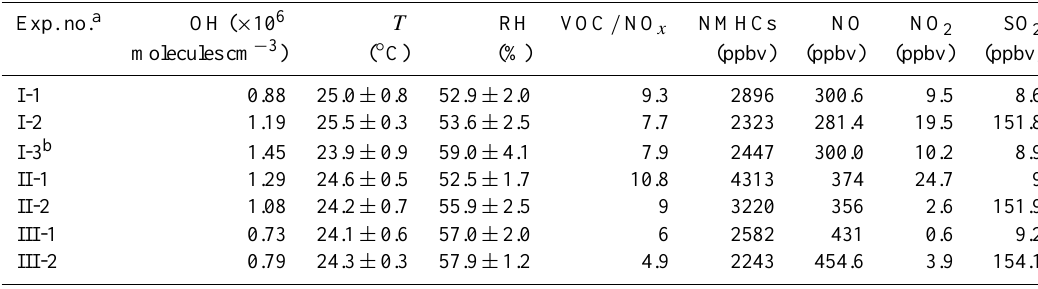
Table 2. Summary of the initial conditions during the photooxidation of LDGV exhaust. Exp. no. a OH ( × 10 6